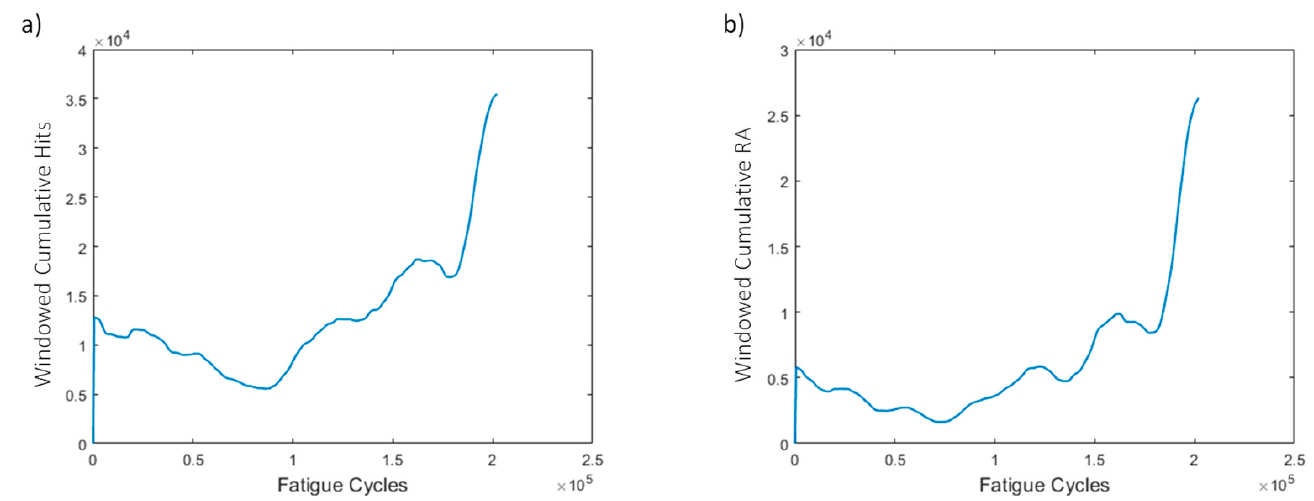
Figure 22. ( a ) Windowed cumulative hits and ( b ) RA vs. fatigue cycles for specimen VA-1 .